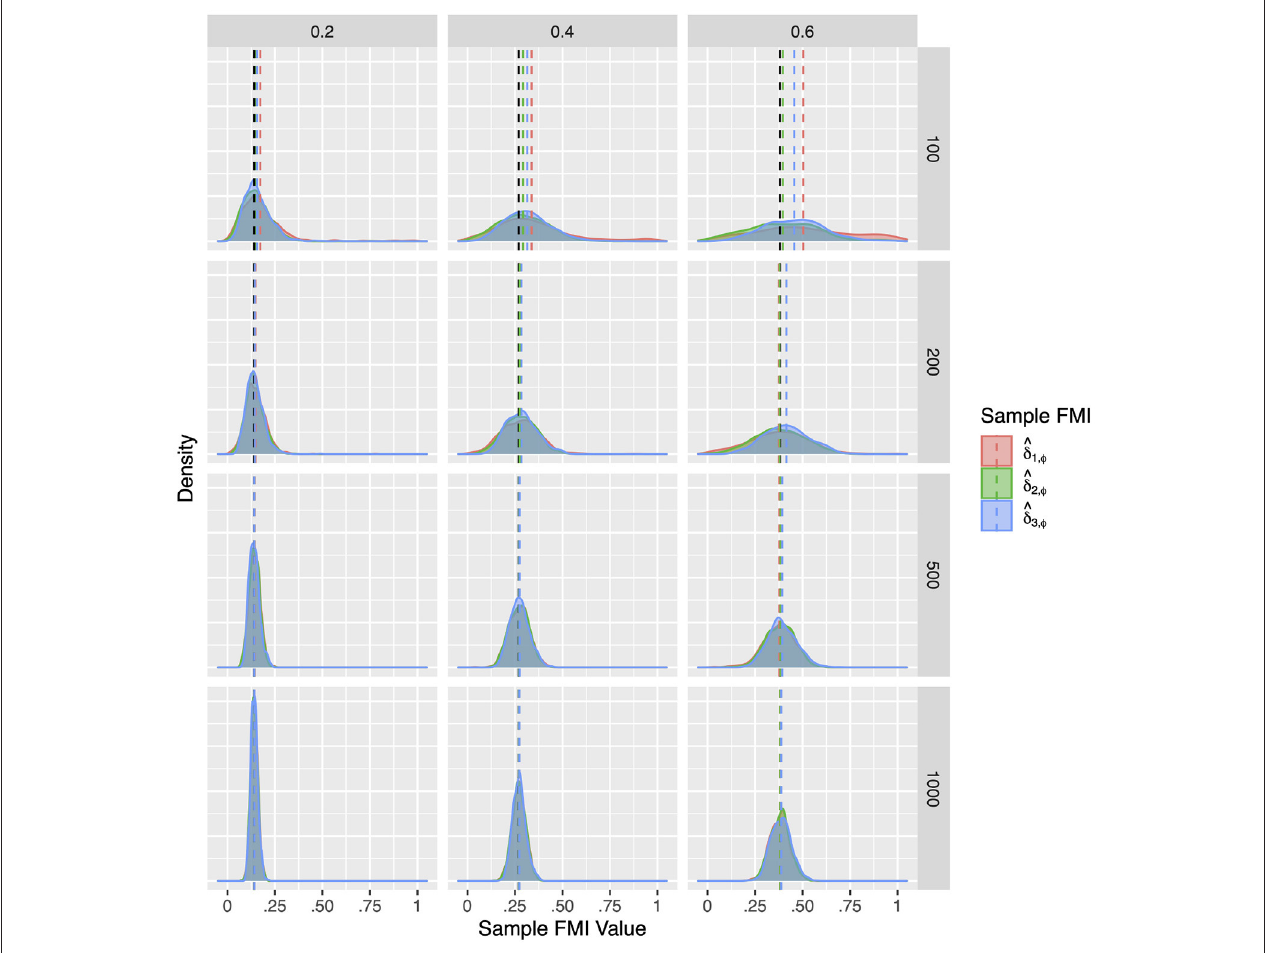
FIGURE 5 | The sampling distribution of FMI for factor correlations in linear MAR. The panel rows correspond to sample sizes of N panel columns correspond to per variable missing rates of 20, 40, and 60%, or overall population missing rates of 10, 20, and 30%. The population FMI value in each panel is given as a vertical black dotted